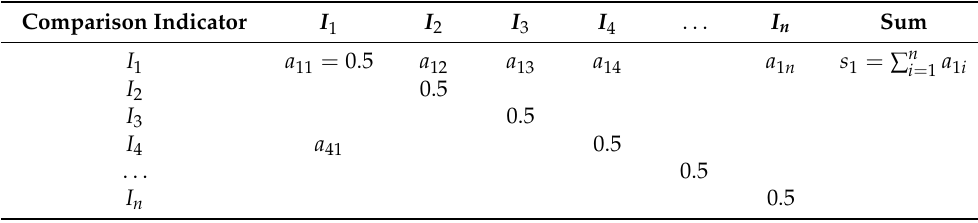
Table 5. Comparison matrix of PCM. Comparison